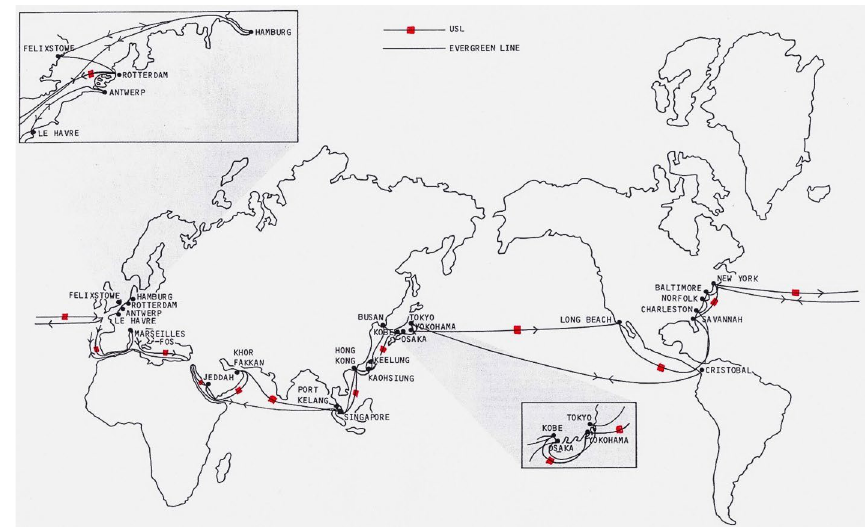
Figure 6. The RTW routes of USL and Evergreen (Drewry 1986)